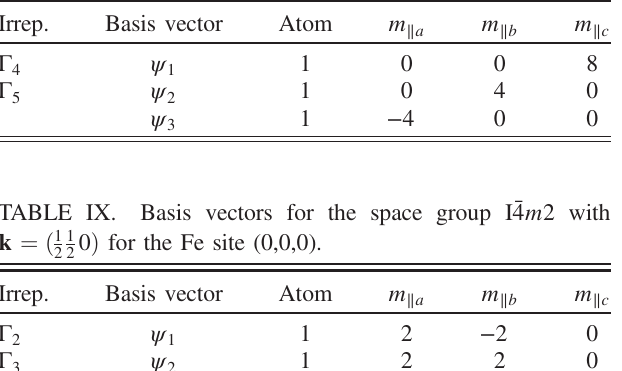
TABLE VIII. Basis vectors for the space group I k ¼ ð 001 Þ for the Fe site (0,0.5,0.25). Irrep.